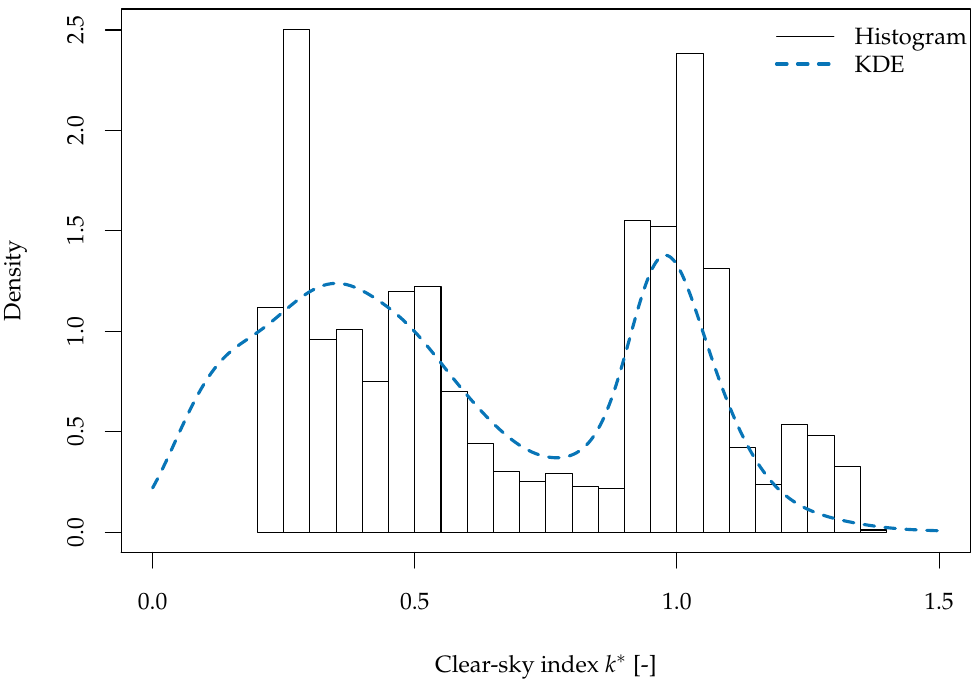
Figure 2. Probability density estimates of clear-sky index k ∗ based on the single-day example time series previously shown in Figure 1 (histogram, black lines), as well as a considerably longer series containing a total of about 4.5 10 6 s worth of single-sensor 1s measurements collected during the · HOPE campaign [138,139] (kernel density estimate, KDE, dashed blue line). The KDE was derived using Gaussian kernels with a smoothing bandwidth (i.e., smoothing kernel standard deviation) of